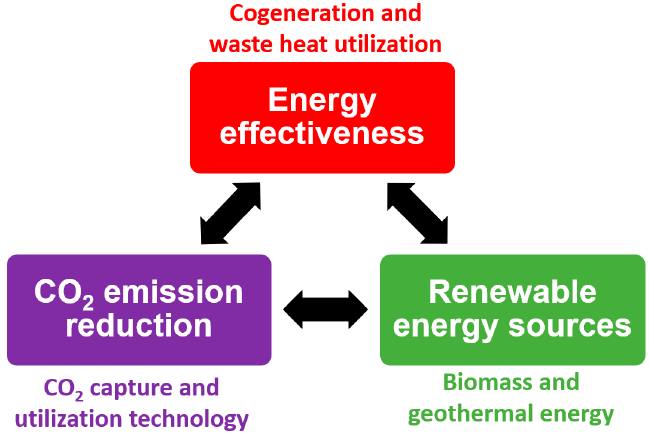
Figure 1. Three pillars of new energy systems.